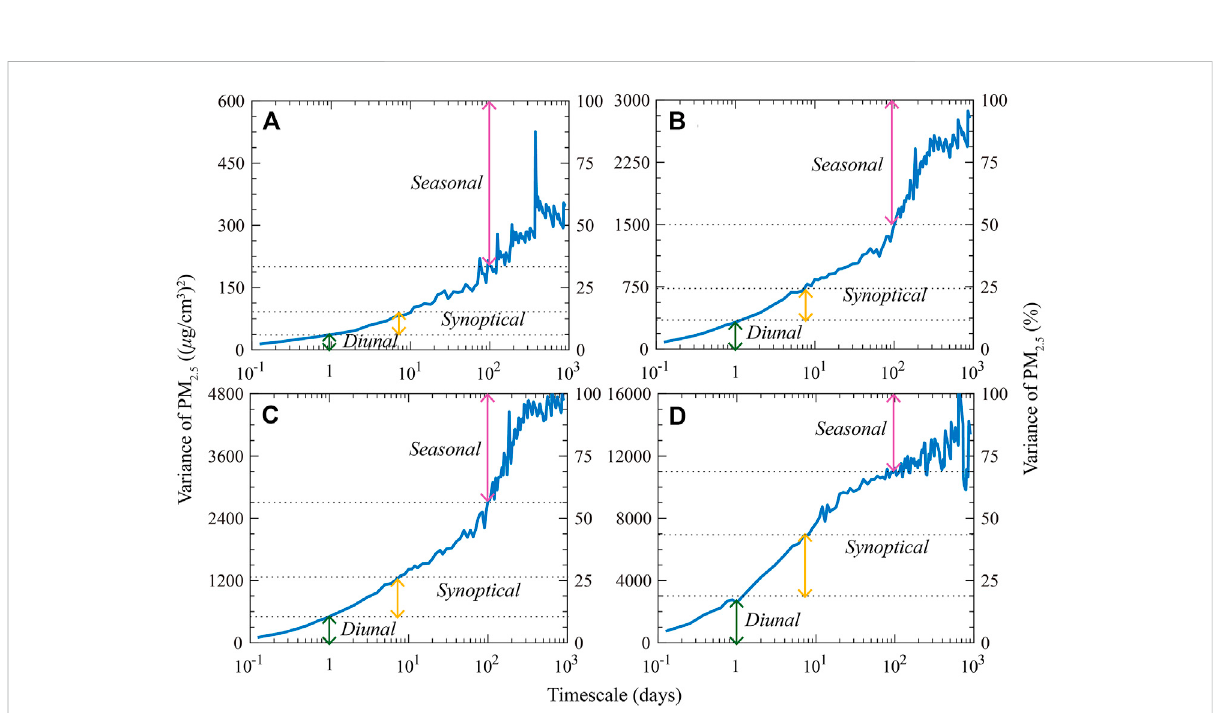
FIGURE 4 Variations ( μ g · m − 3 ) 2 and proportions (%) of PM 2.5 concentration variance at different timescales in (A) region I, (B) region Ⅱ , (C) region Ⅲ and (D) region Ⅳ of Xinjiang from 2013 to